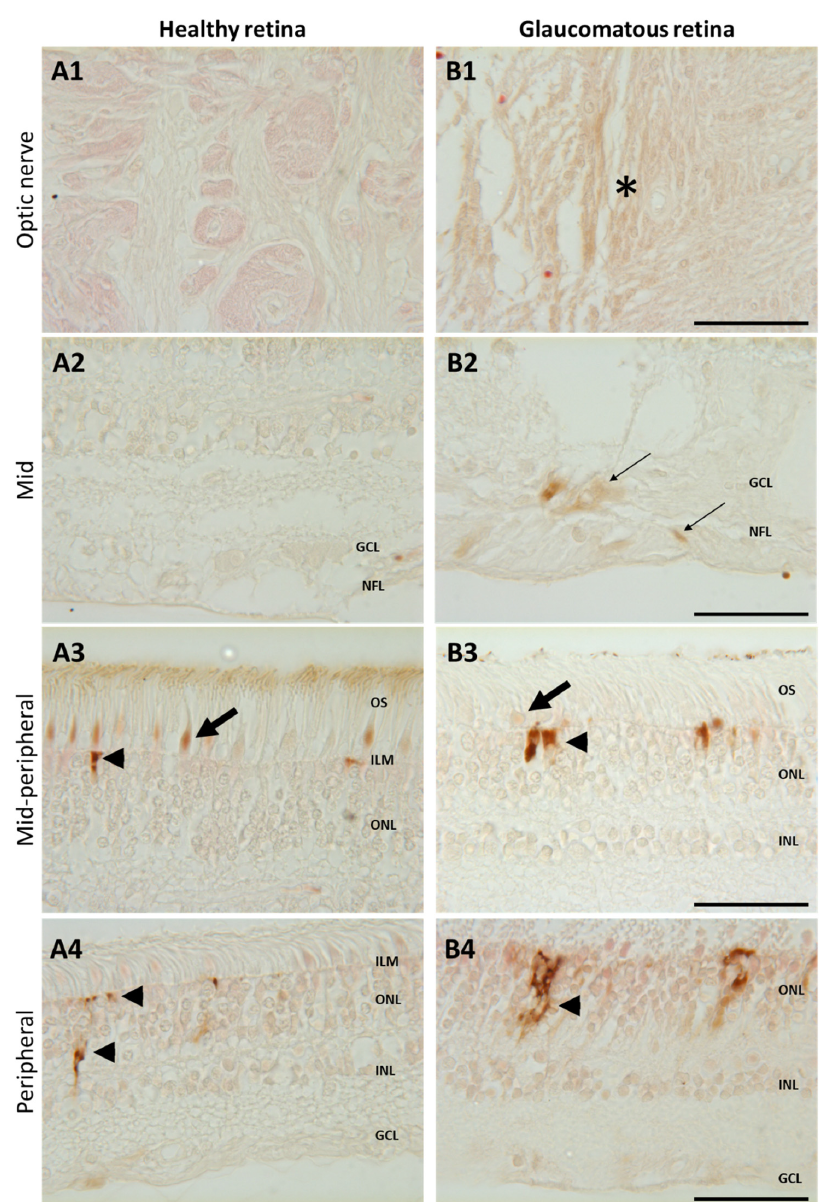
Figure 5. Increased iron in glaucomatous versus healthy human retinas. Representative images of enhanced Perls’ reaction realized on human healthy eyes ( A ) and glaucoma-affected eyes ( B ) observed in the optic nerve ( A1 , B1 ), in the mid- and mid-peripheral retina ( A2–3 , B2–3 ), and in the peripheral retina ( A4 , B4 ). In healthy retina, iron was localized in cone outer segments (( A3 ) , arrows) and in the Müller glial cell end-feed at the inner limiting membrane (ILM) (( A3 ) , arrowhead) and in processes (( A4 ) , arrowhead). Glaucomatous retinas present iron deposits in optic nerve (( B1 ) , asterisk) and in the nerve fiber and ganglion cell layers (( B2 ) , thin arrow) and increased iron staining in Müller cells (( B3 , B4 ), arrowheads) but decreased in cone outer segments (( B3 ) , arrow). Scale bar: 50 µm. GCL: Ganglion cell layer; ILM: Inner limiting membrane; INL: Inner nuclear layer; NFL: Nerve fiber layer; ONL: Outer nuclear layer. OS: Outer segment.